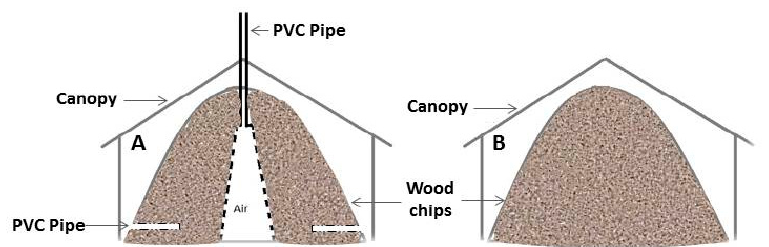
Figure 1. Cross-section of protected piles with dome ( A ) and protected piles ( B ).